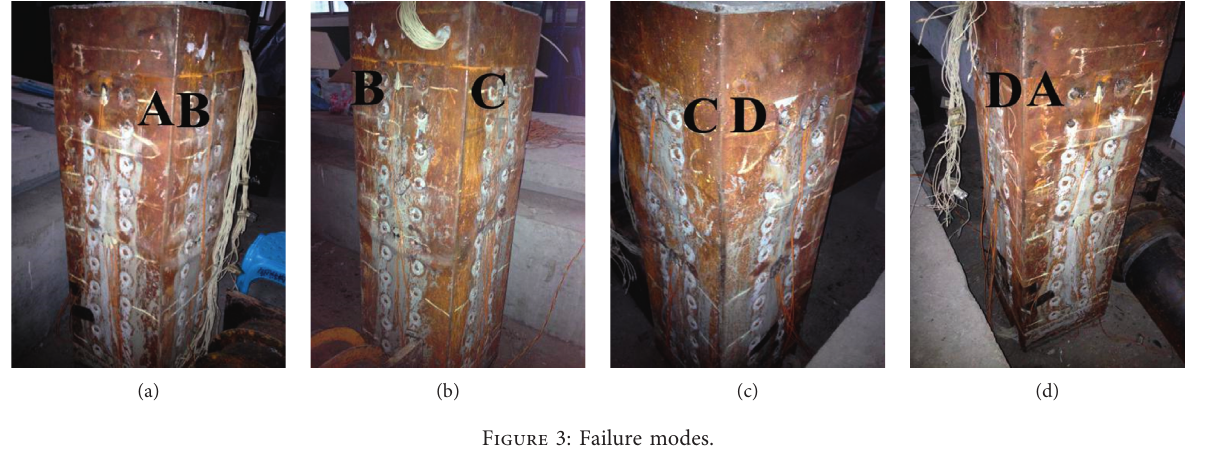
Figure 3: Failure modes.